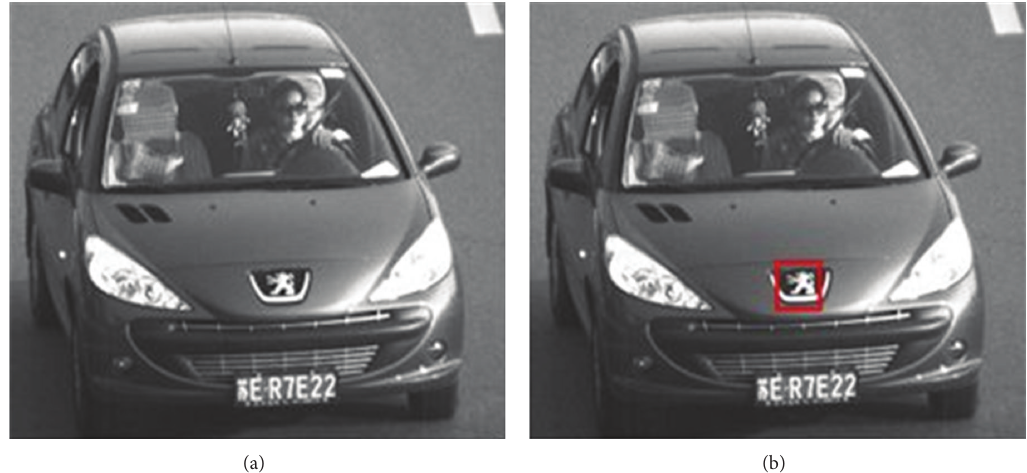
Figure 20: The left-side image is obtained from SVM and the right-side is the result of Gentle Adaboost.